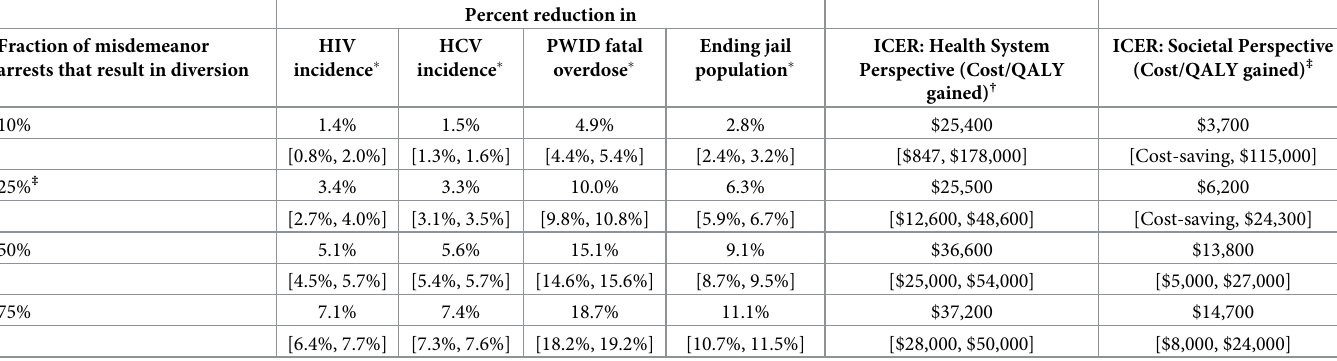
Table 3. Health and demographic outcomes: One-way sensitivity analysis on probability of enrollment in the diversion program.